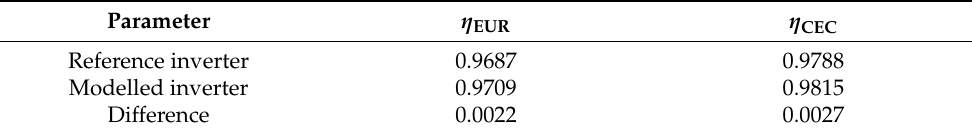
Table 3. Weighted efficiency evaluation of the reference inverter and DSPI digital twin.